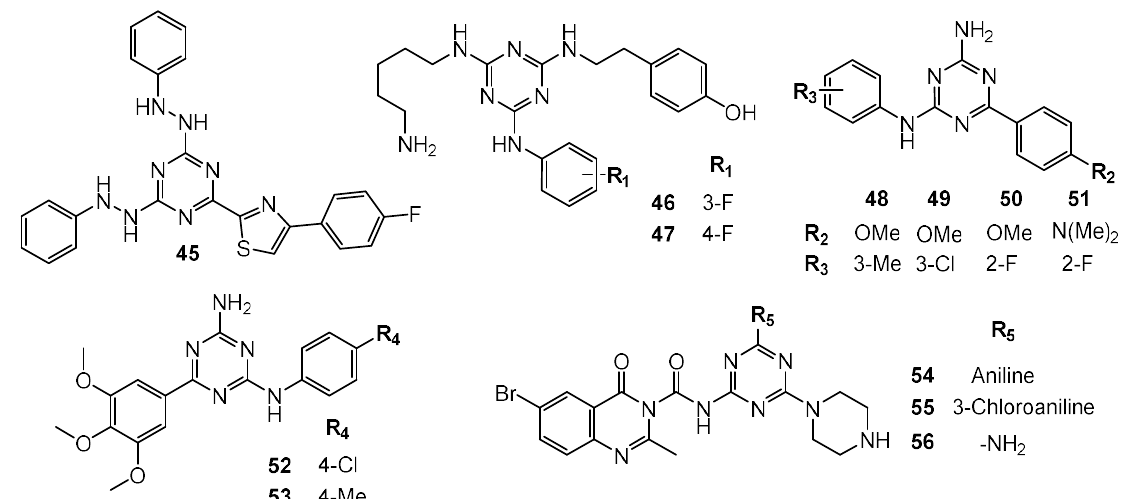
Figure 11. Structures of compounds 45 – 56 .